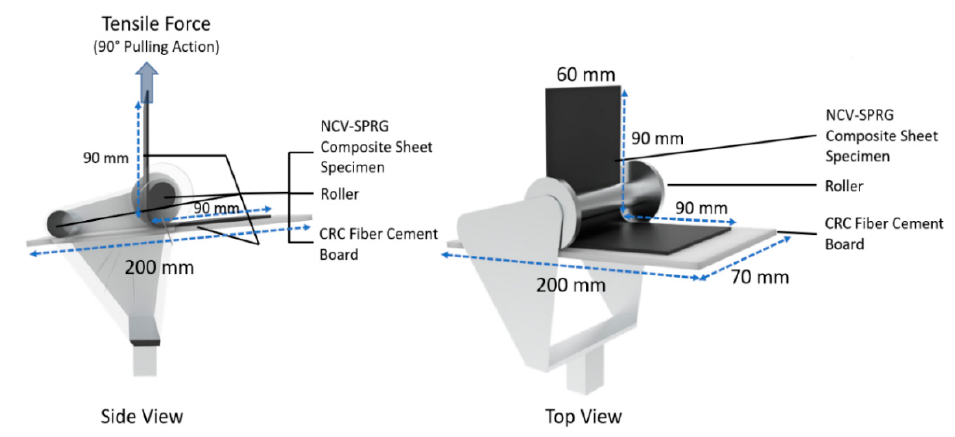
Figure 4. The conventional peel-off testing apparatus.